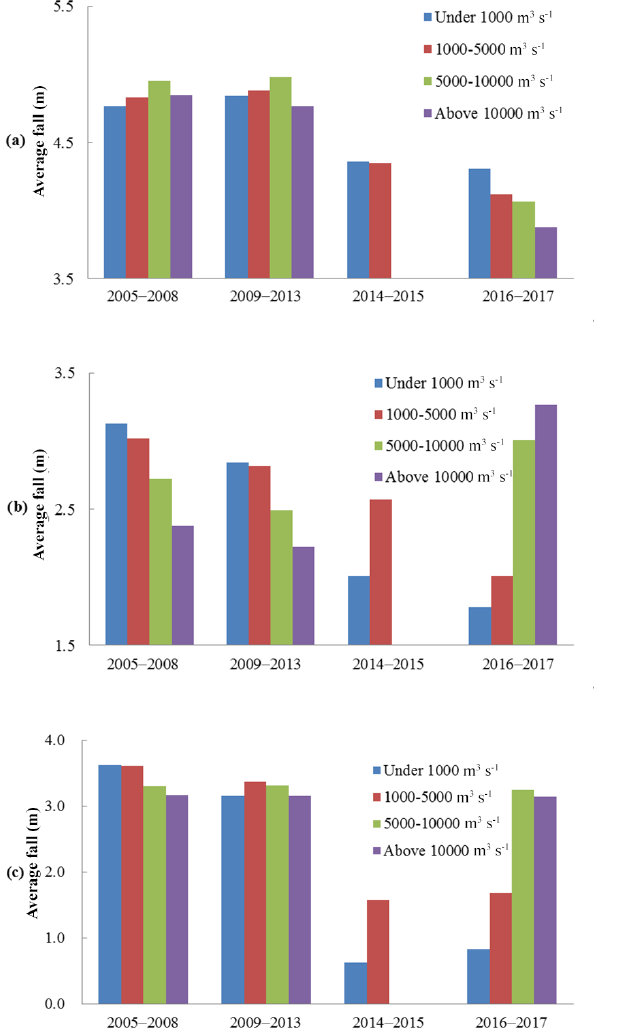
Figure 3. Surface water fall in different reaches of the Hanjiang River for different discharge ranges and time periods in 2005–2017, (a) Zhuandouwan-Huangzhuang reach, (b) Huangzhuang-Datong reach, and (c) Datong-Shayang